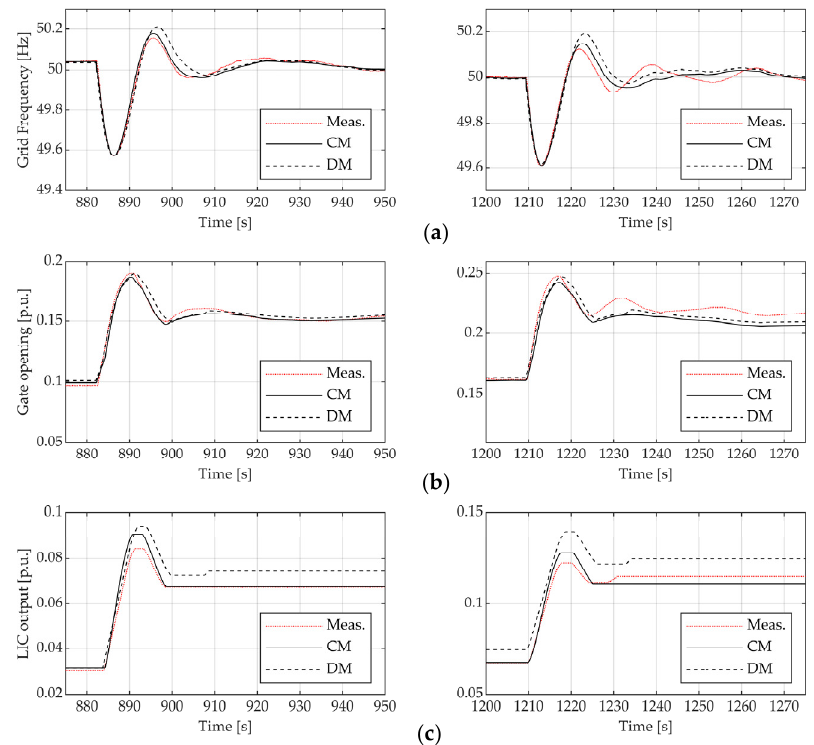
Figure 9. Comparison between simulation results and measurement recordings of the S L1 and S L2 events for ( a ) the grid frequency, ( b ) the gate opening of G1, and ( c ) the output signal of the LIC of G1 for different mathematical models.